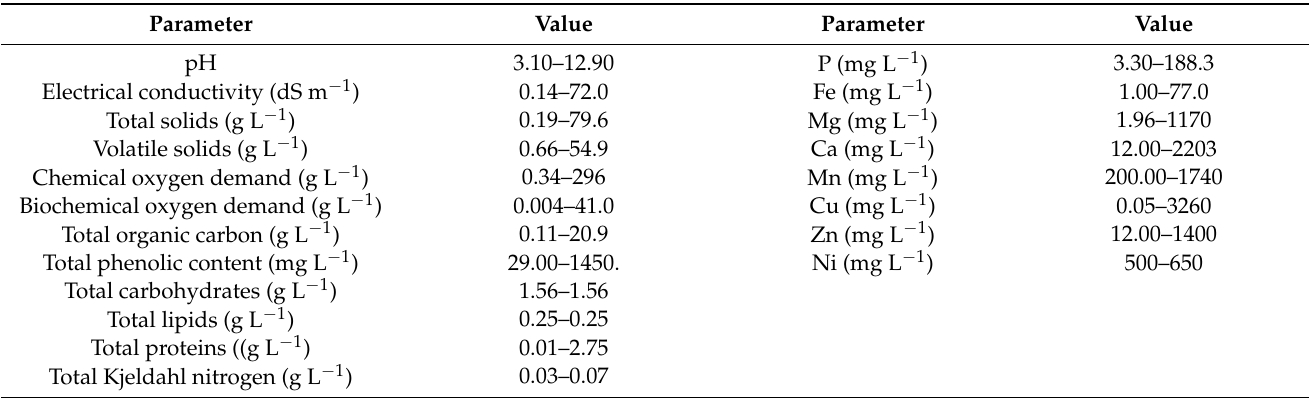
Table 1. General characterization of winery